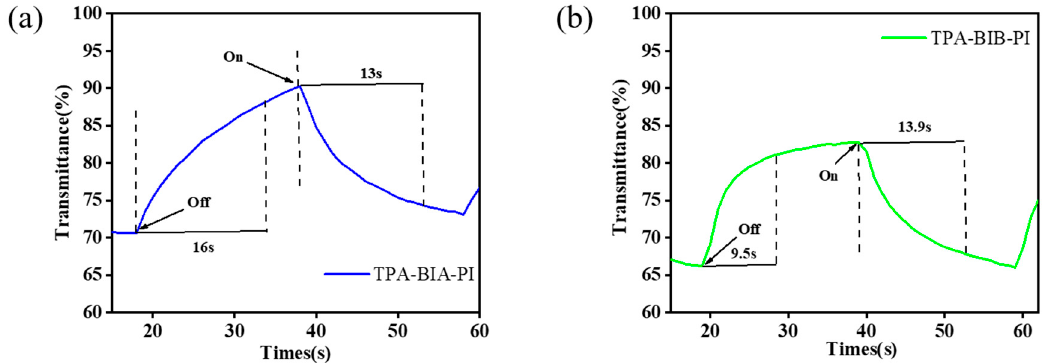
Figure 11. Optical switching time of TPA-BIA-PI at 755 nm ( a ) and TPA-BIB-PI at 762 nm ( b